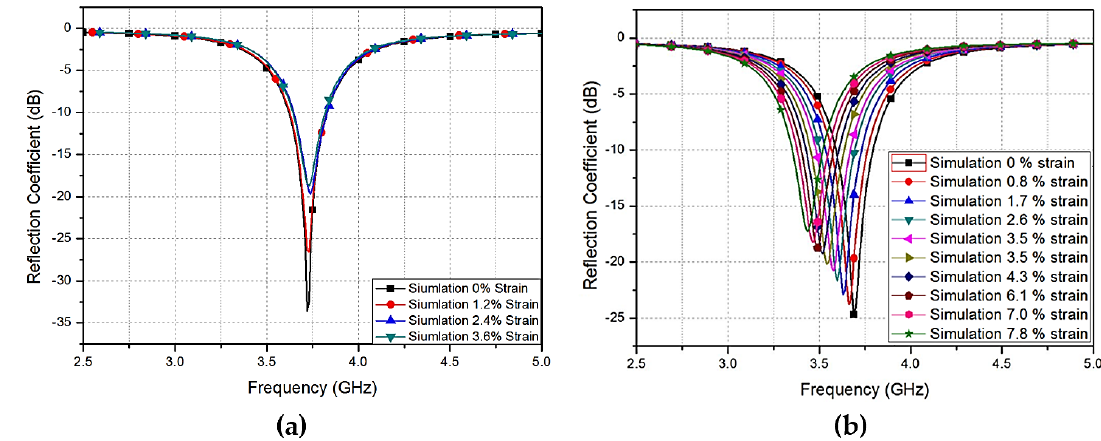
Figure 19. Simulated reflection coefficients with different patch: ( a ) widths; and ( b ) lengths [78].